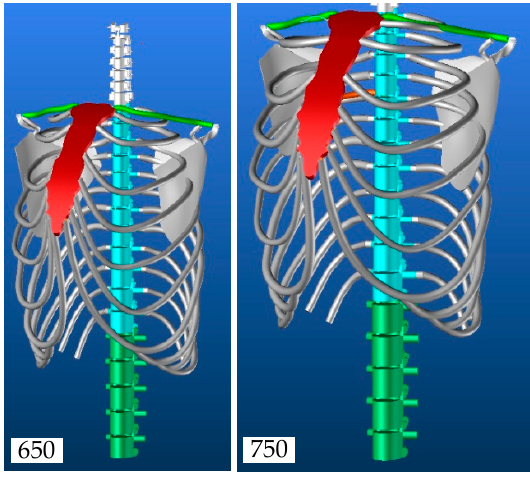
Figure 15. The evolution of the thorax model.